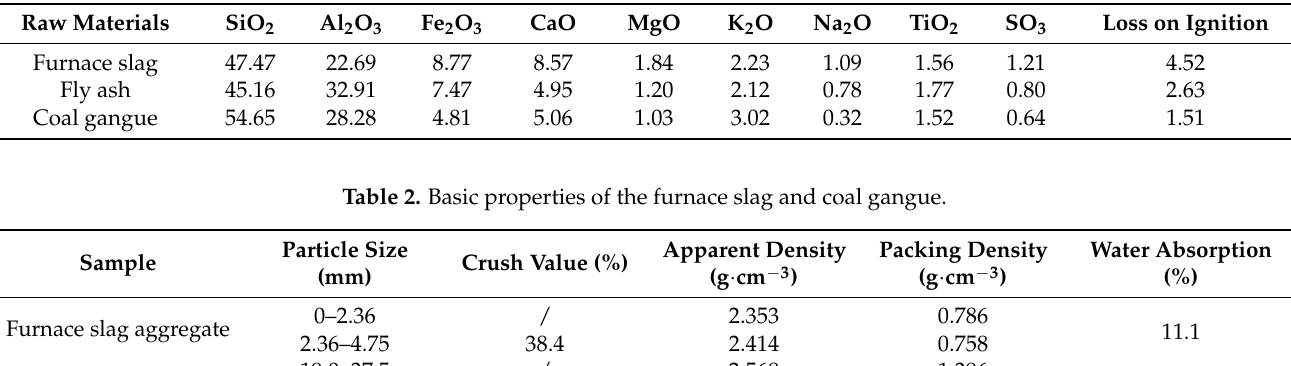
Figure 1. XRD patterns of furnace slag and fly ash: ( a ) furnace slag, ( b ) fly ash, and ( c ) coal gangue. Table 1. Chemical composition (mass fraction (%)) of furnace slag and fly ash.